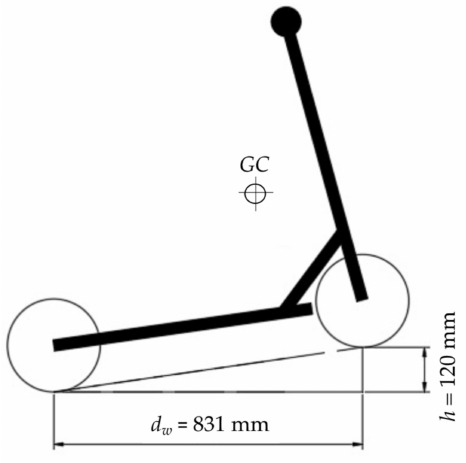
Figure 5. Centre of gravity of the e-scooter.